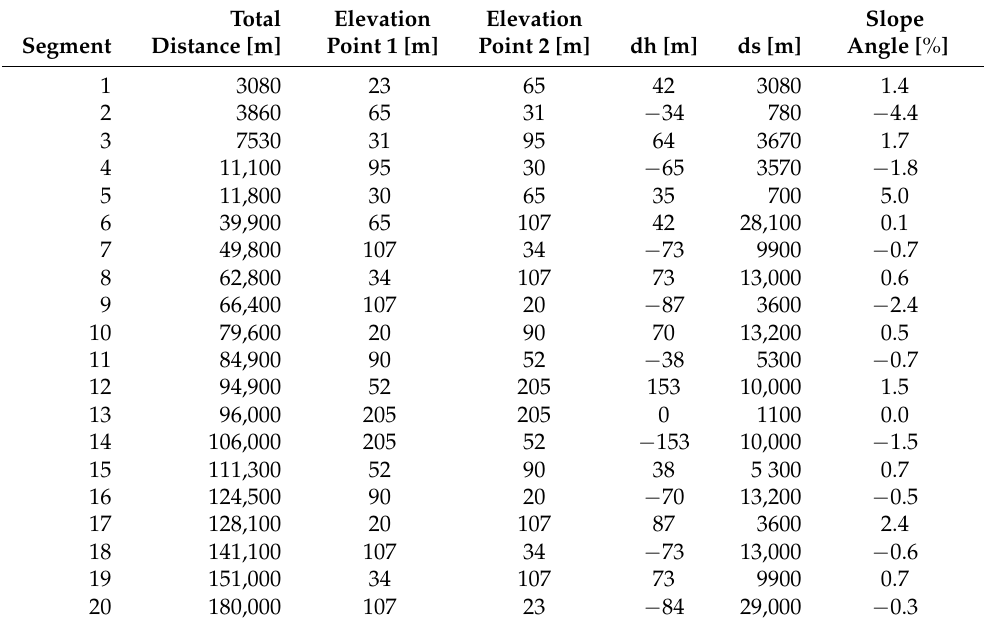
Table 3. IM Hawaii course